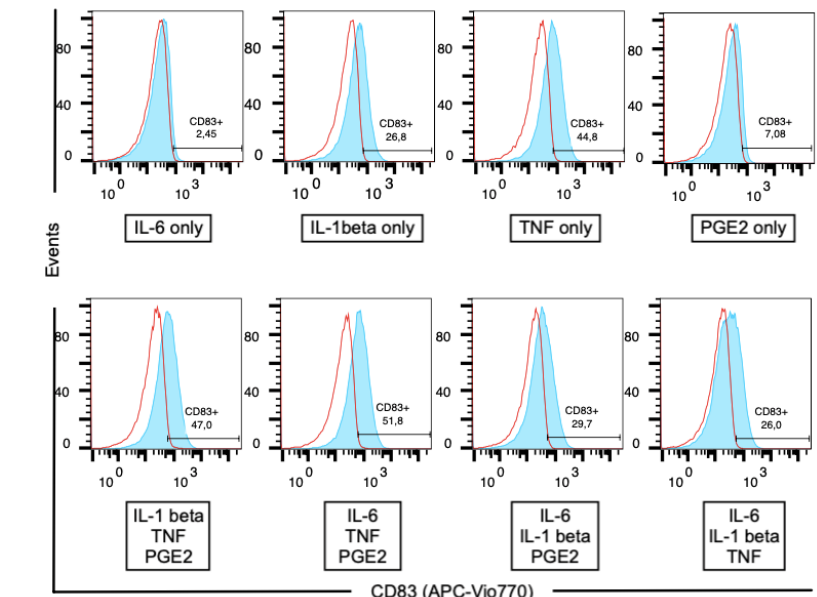
Figure 3. CD83 Flow cytometry ( A ) CD83 upregulation on A673 cells after addition of either IL-6, IL-1 𝛽 , TNF and PGE 2 only, respectively after two doses of IL-4 and GM-CSF (day six of in vitro culture). ( B ) CD83 upregulation on A673 cells after addition of three out of four cytokines (IL-6, IL-1 𝛽 , TNF and PGE 2 ) of the DC maturation cocktail on day six. Quad- rants were set after staining a control sample for APC-Vio770 isotypes (red open histogram) for each cytokine group tested (blue histogram). All experiments were performed in independent